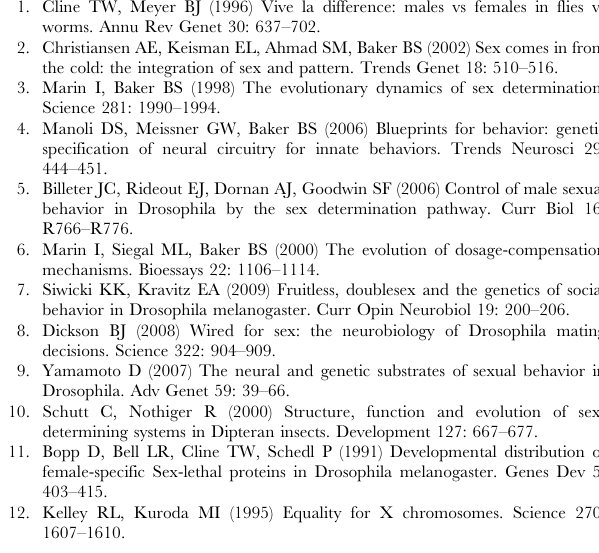
Figure S5 dsx GAL4 is expressed in tissues associated with the genitalia of males and females. Expression of UAS-mCD8::GFP membrane-bound GFP reporter (green) and autofluorescence of cuticular elements (magenta) are shown for adult male (A–E) and female (F–J) samples. Confocal Z projections. (A) Seminal vesicle (bracket) and cross-section through ejaculatory duct (ED) (arrow). (B) Ejaculatory bulb (EB). (Bi) Cross-section through EB (bracket) and superficial view of associated muscles (arrow). (Bii) Superficial view of EB (bracket). (C) Terminal epithelium of the testis (arrow) and surface of the ED (bracket). (D) Muscles (arrow) associated with cuticular elements (barbed arrow) of the male genital apparatus. (E) Muscles (arrow) associated with cuticle (apodeme) of the penis apparatus (barbed arrow). Adipose tissue is also seen (asterisk). (F) The common oviduct bifurcates into the lateral oviducts (arrows), which connect to the base of the ovaries (white asterisks). Adipose tissue is also seen (black asterisk). (G) Spermatheca (arrow), a sperm-storing organ, and associated adipose tissue (asterisk). (H) Tracheoles (arrow) associated with the ovary. Surface of ova are magenta. (I) Muscles (m) associated with the paired cuticular vaginal plates (vps). Parallel rows of vaginal teeth bristles (arrows pointing to short bristles that are visible in magenta and black). Epithelium (e) underlying the vaginal plate cuticle. Cross-section of lateroventral view. (J) Muscles (bracket) associated with the cuticular analia dorsal to the vaginal plates. Cross-section. Found at: doi:10.1371/journal.pbio.1000365.s005 (5.38 MB